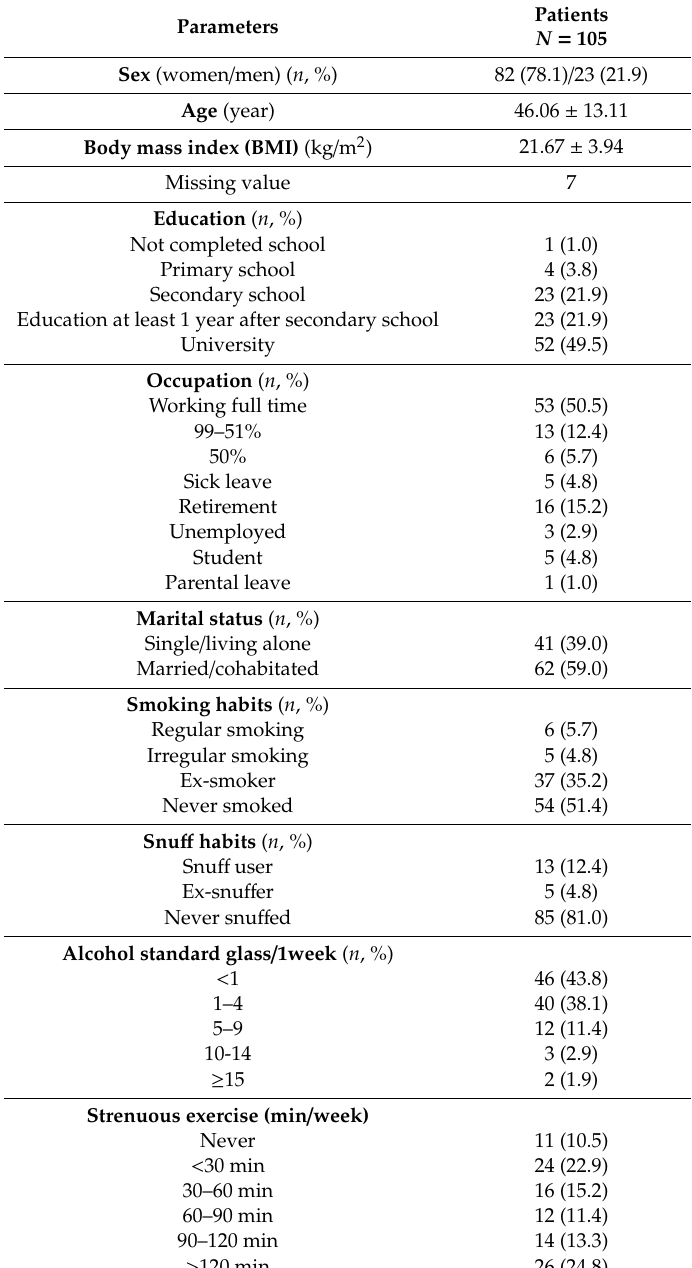
Table 1. Basal characteristics in the study